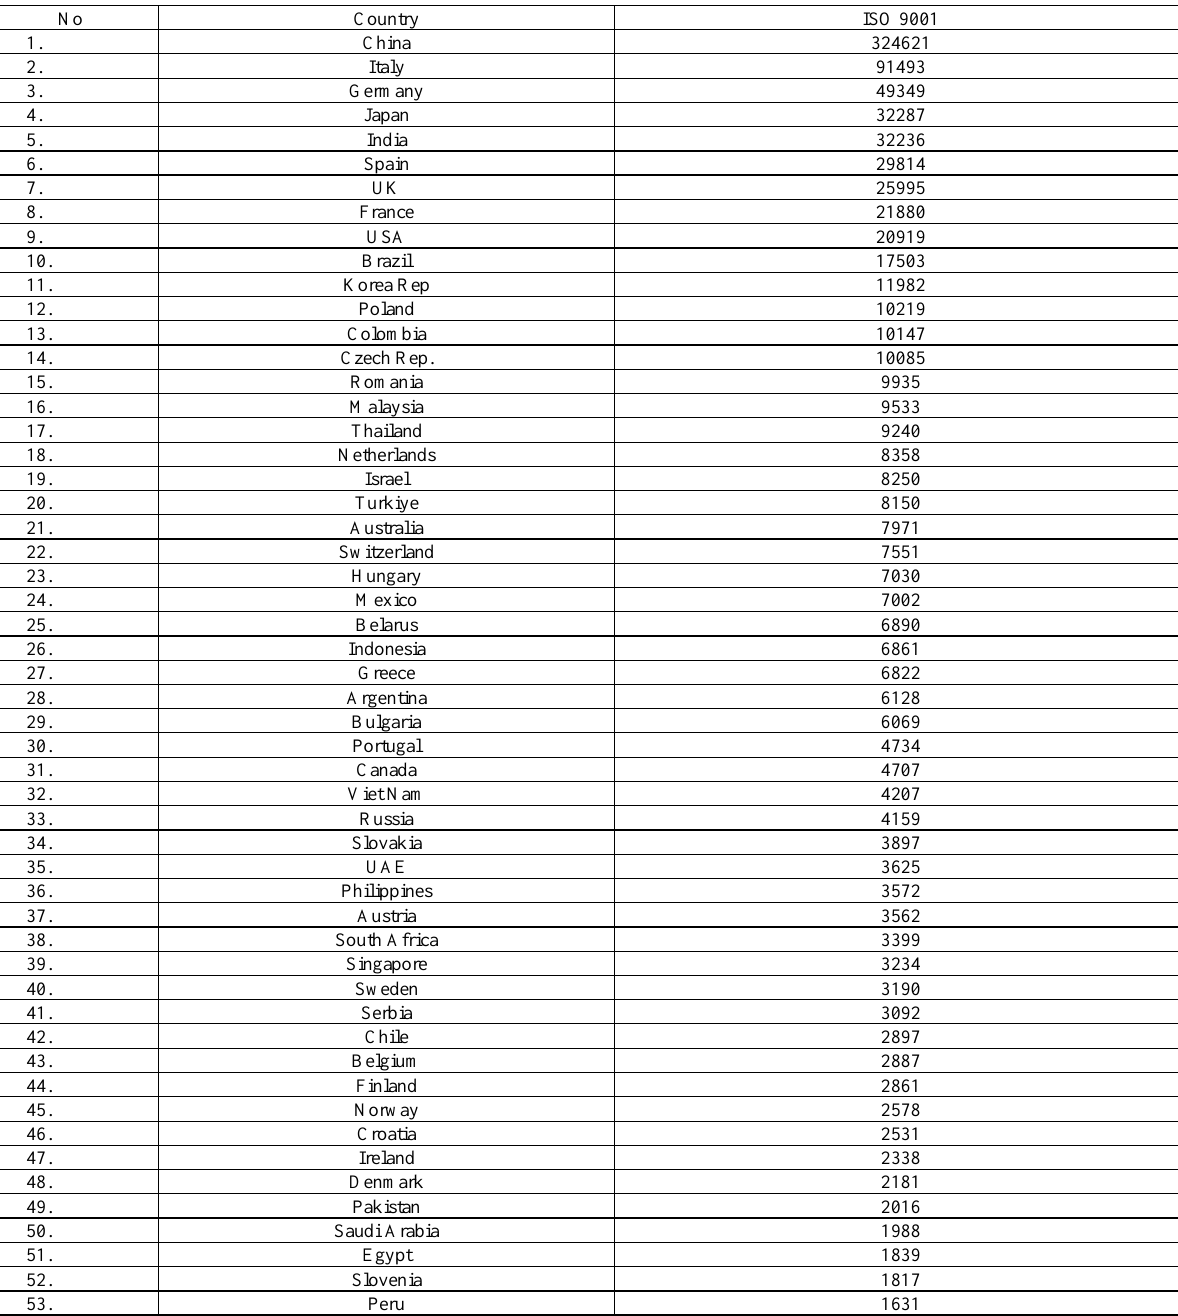
Table 2. List of countries for ISO 9001 certificates issued based on the higher value of ISO 9001 certificates issued (136 countries worldwide, drawn from the author of this paper from the ISO table of the list of